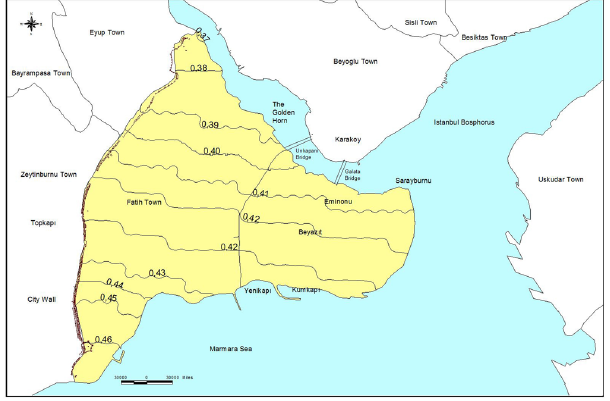
Fig. 13. SA ( T = 1.0s) contour map for a 10% probability of ex- ceedance in 50yr for the historical penninsula of Istanbul (Poisso- nian model) (˙Ince, 2005).